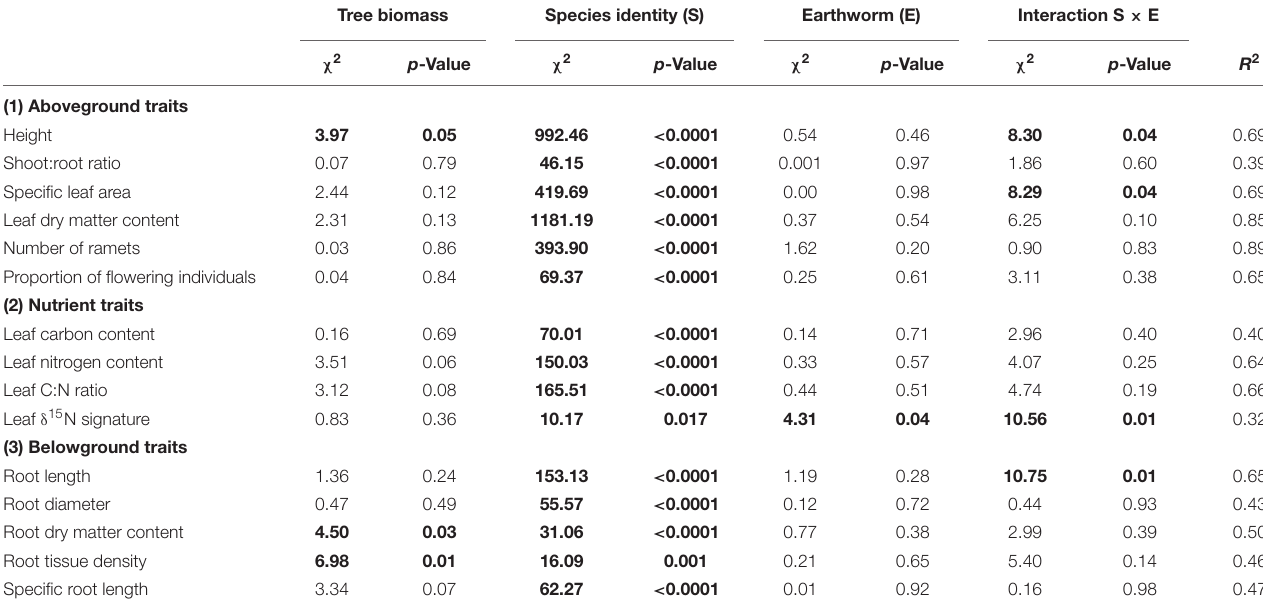
TABLE 1 | Summary of the models on the effects of earthworms on the different plant functional traits ( χ 2 , p -value, and conditional or marginal R 2 in the case of the number of